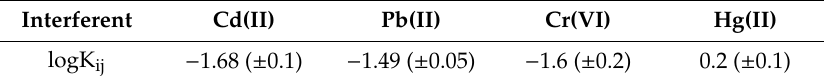
Figure 6. Slopes of the electrode function of LignoBoost ® kraft lignin-based sensor. Mean values of three calibrations with standard deviations are shown. Table 1. Logarithm of the selectivity coe ffi cients, logK ij , of LignoBoost ® kraft based sensor to copper(II) determined using mixed solution method. Mean values of four measurements with standard deviations are shown.